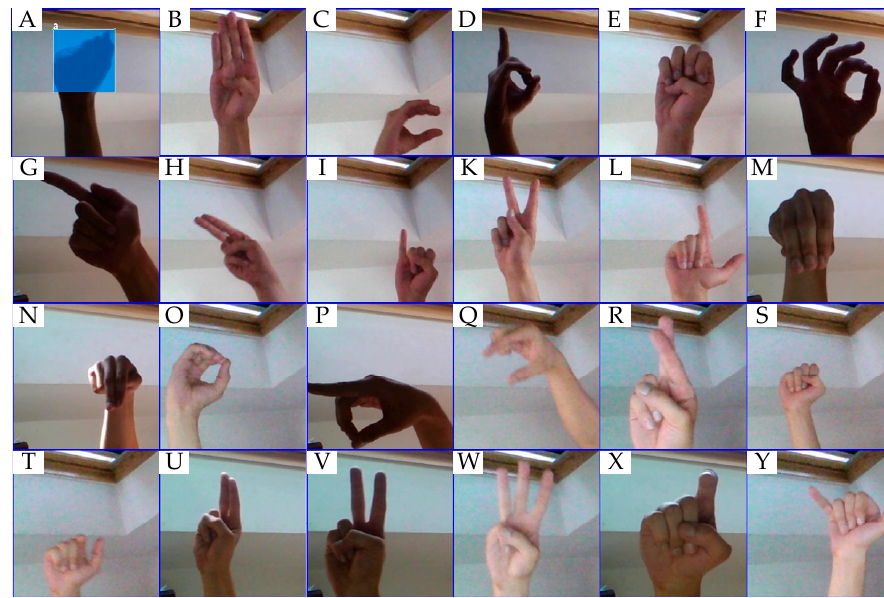
Figure 4. Samples of the American Sign Language fingerspelling dataset.